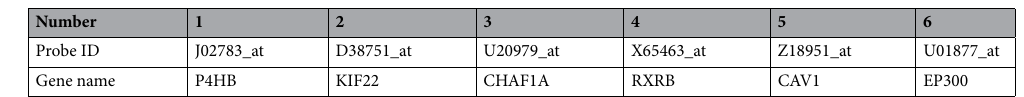
Table 3. The six most important genes and their probe IDS selected by the proposed